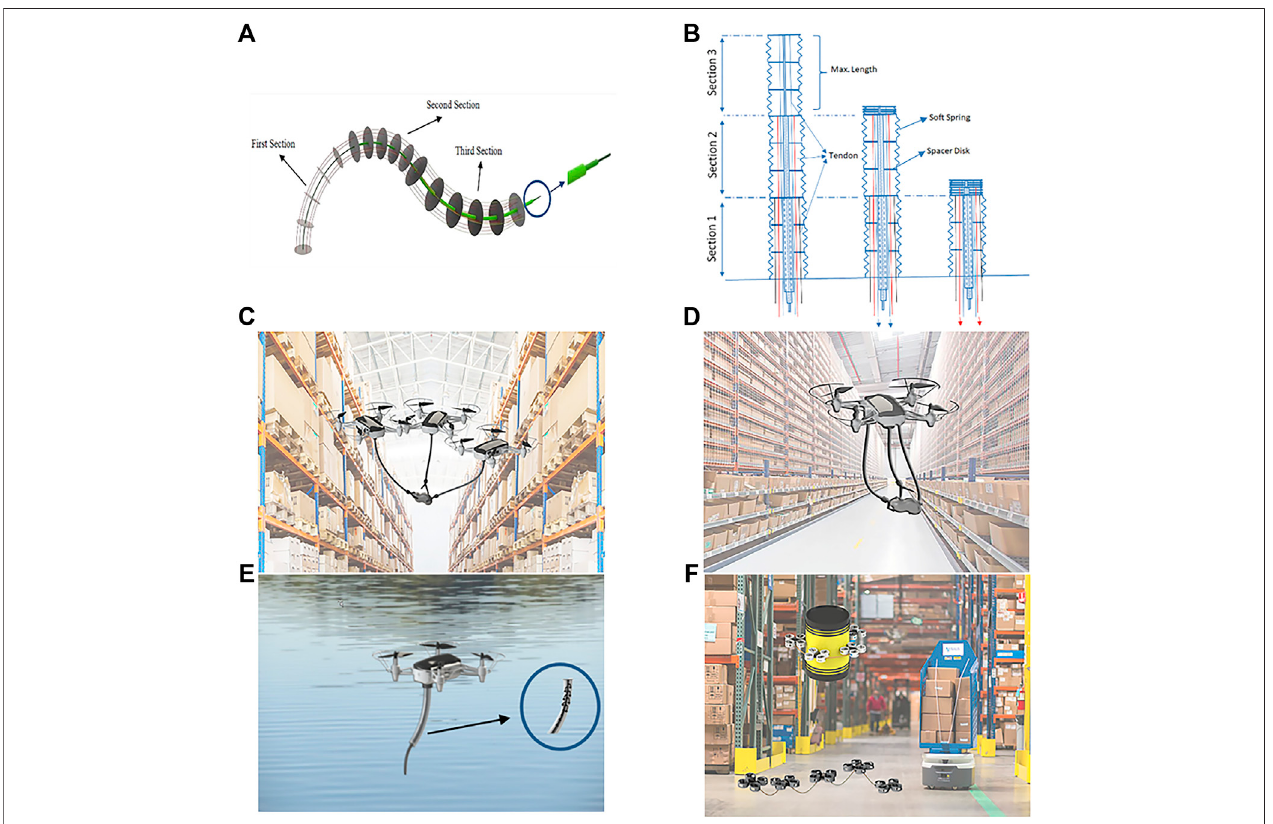
FIGURE 1 | (A) Schematic con fi guration of a 3 section tendon-driven concentric tube CR; (B) proposed design for a typical CR with three tubes. Conceptual platforms: (C) cooperative platform-type (i); (D) cooperative platform-type (ii); (E) self-container; and (F) whole-body.